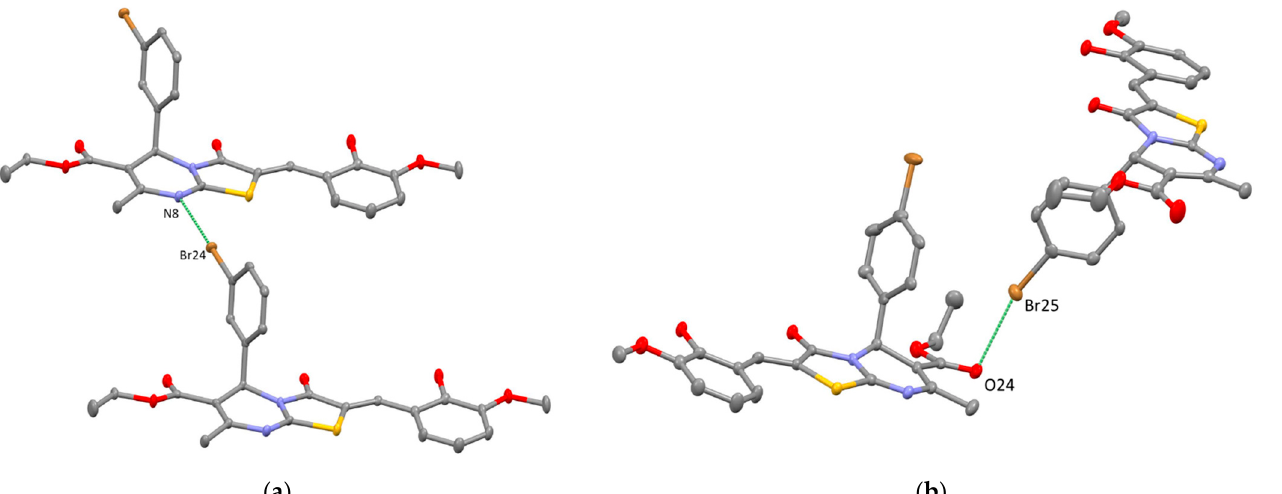
Figure 7. ORTEP-view of supramolecular dimers resulting from intermolecular halogen bonding in the crystals of compounds 5 ( a ) and 6 ( b ). The ellipsoids are presented with 50% probability and the H-atoms are omitted for clarity. Halogen bonding is presented by green dotted lines.